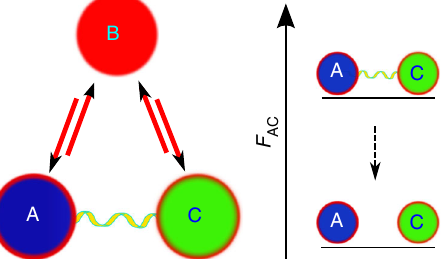
Fig. 3 Violation of the zeroth law. In the presence of correlations, the notion of equilibrium is not an equivalence relation. Consider 3-party state ρ B ⊗ ρ AC with all marginals thermal states. The thermal equilibria A +( B and B +( C imply that A, B and C share the same temperature. But, in the presence of correlations between A and C, that does not assure the equilibrium A +( C . Therefore, the transitive property of the equivalence relation is